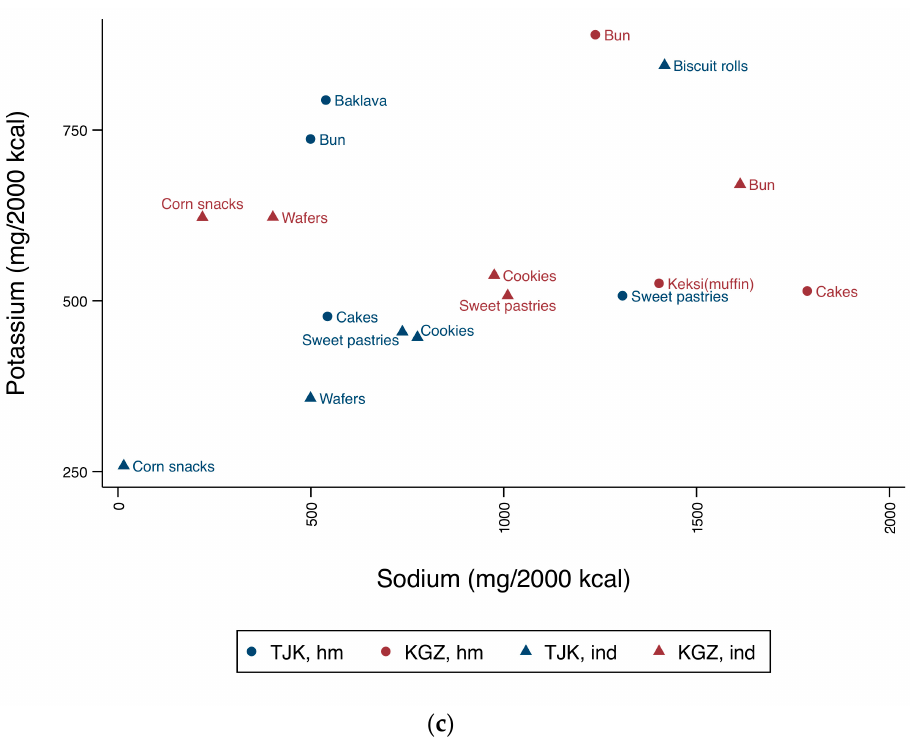
Figure 3. Distribution of average of sodium (Na) and potassium (K) contents (mg/2000 kcal) of the most commonly available home-made (hm) and industrial (ind) foods in Tajikistan (TJK) and Kyrgyzstan (KGZ) relative to the World Health Organization (WHO) sodium and potassium recommendations (less than 2000 and at least 3510 mg/day, respectively); 2000 kcal was assumed as the average energy requirement for adults. ( a ) A general view of these nutrients’ content in all foods collected from both countries, and zoomed-in views of foods that tended to have contents that either ( b ) exceeded sodium upper recommended limits up to 8000 mg Na/2000 kcal and were below minimum potassium recommendations down to 650 mg K/2000 kcal; or ( c ) were below sodium upper recommended limits and below 1000 mg K/2000 kcal.